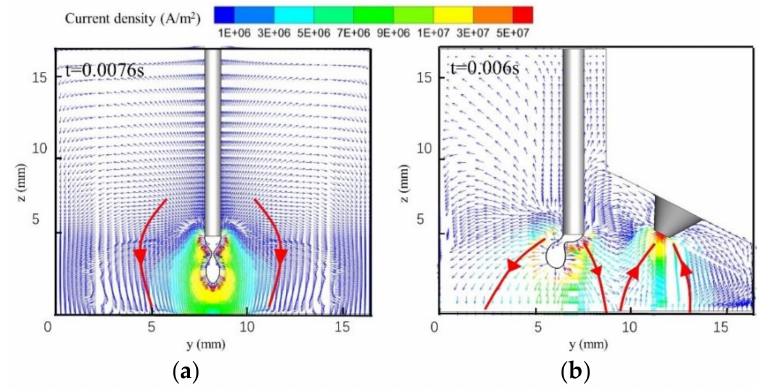
Figure 6. Arc current density distributions: ( a ) MIG; ( b ) TIG-MIG.